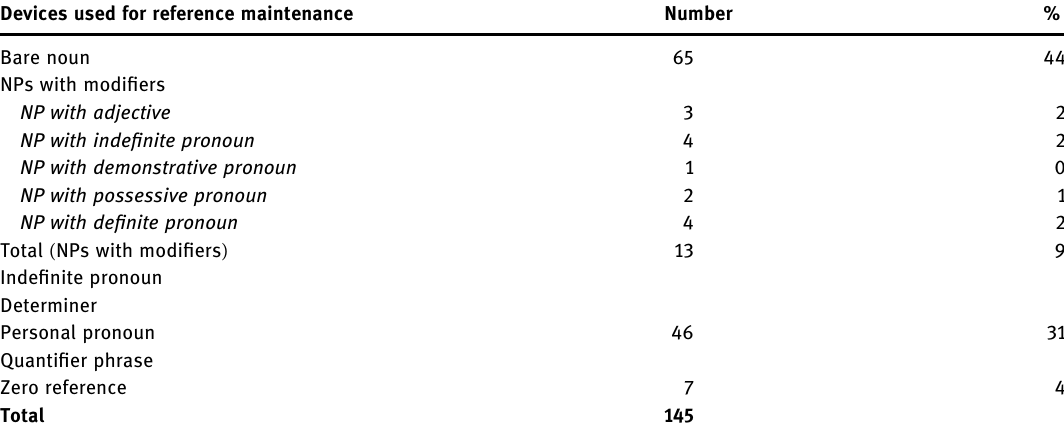
Table 3: Di ff erent devices used for referent maintenance Devices used for reference